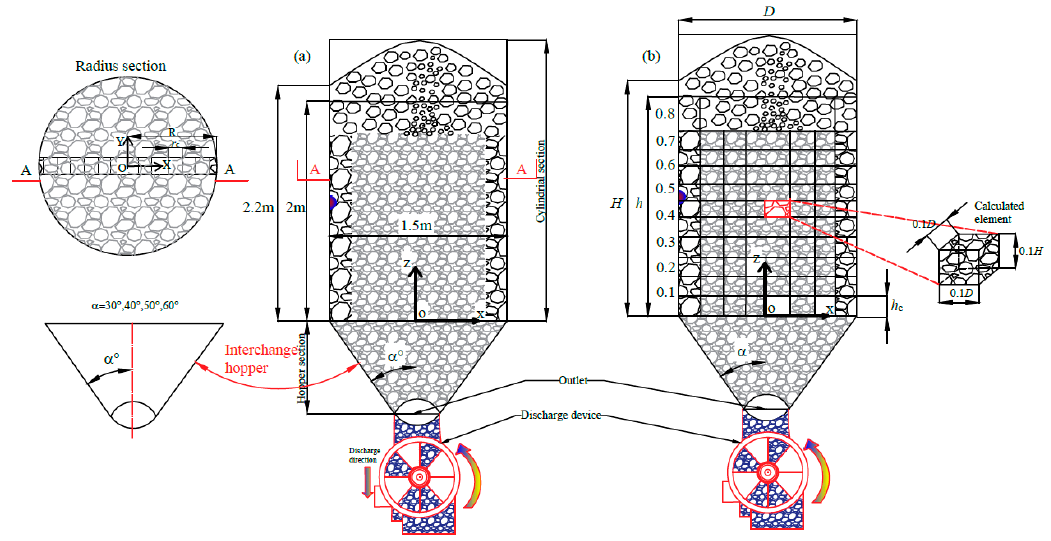
Figure 1. Schematic of the geometry used for ( a ) the experiment and ( b ) the numerical calculation.